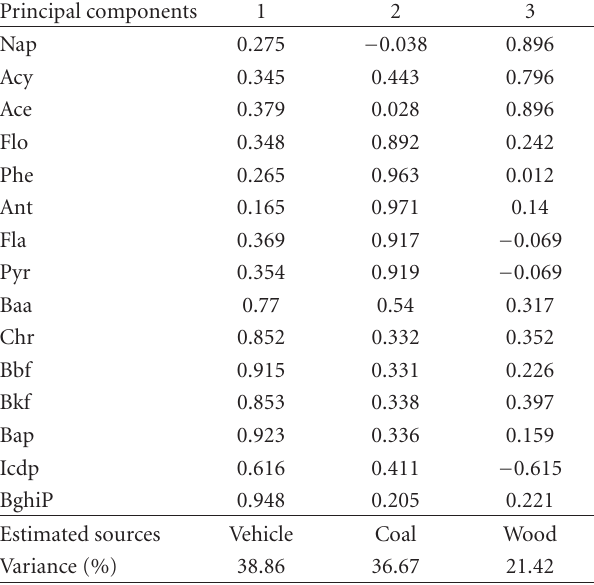
Table 3: Rotated component matrix of PAHs in the gaseous and particulate phases at Lake Small